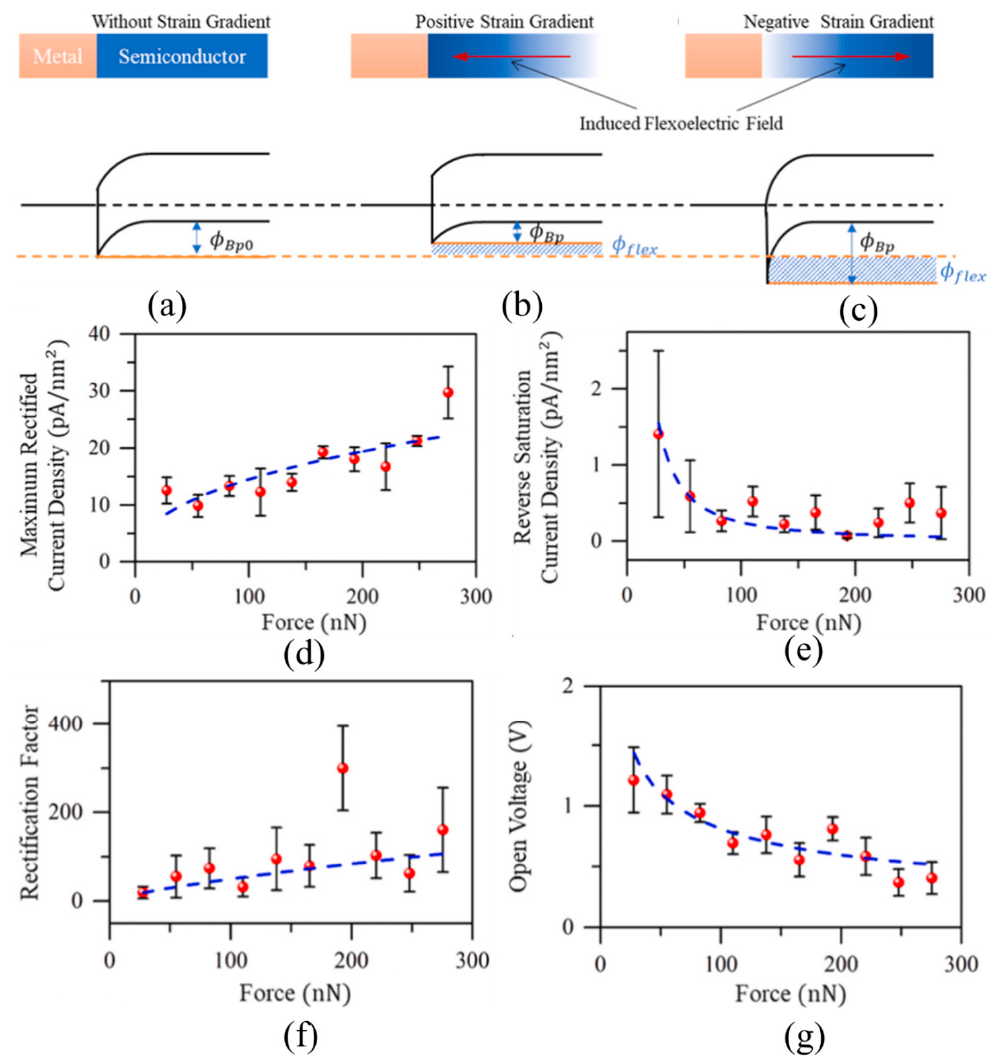
within the grey boxes. Horizontal arrows indicate the corresponding fast scan direction. ( b ) NVC profiles along lines M1, M2, M3, and M4. M1 and M4 are placed 0.5 μ m away from the borders V (cid:0)(cid:0) ‐ enriched region (inside the red box) and the pristine region (outside the red box). between the O Horizontal black lines in ( b ) indicate the background, which is used to estimate the net change in the NVC. The NVC profiles were averaged over a 0.5 μ m wide averaging window. Reprinted with permission from [101]. Copyright 2020 Springer Nature.